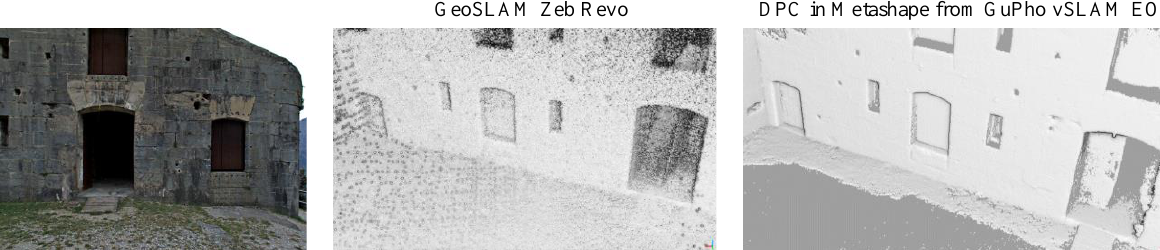
Figure 11. A close up view of the main entrance of Batteria di Mezzo fort in Riva del Garda, Italy (left) and the two point clouds of its facade, surveyed with the GeoSLAM Zeb Revo (middle), and the proposed prototype (right), respectively. Using the trajectory obtained in Figure 10c as initial guess for the image orientation, with an exhaustive matching of the tie points, bundle adjustment, and thus “loop closure”, the scaling error is reduced to 0.3% and the loop closure is 3.6 cm (Figure 10d).